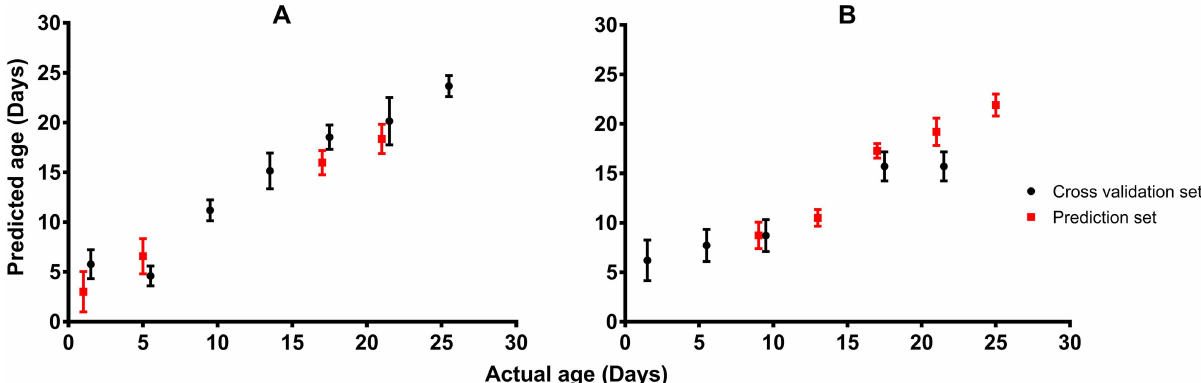
Fig 3. Mean (95% CI) age prediction of female (A) and male (B) of wild-type Ae . aegypti mosquitoes using